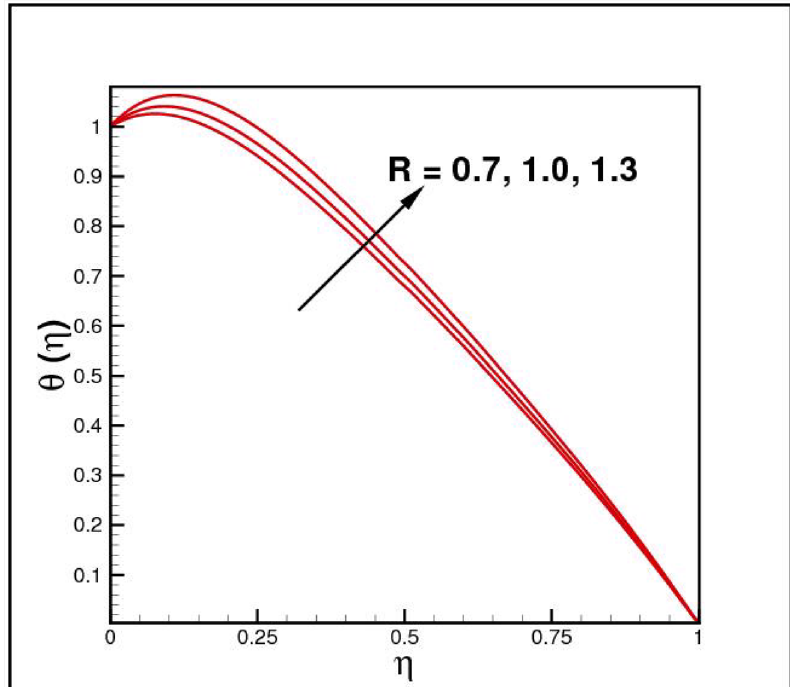
Figure 9. Impact of R on θ ( η ).